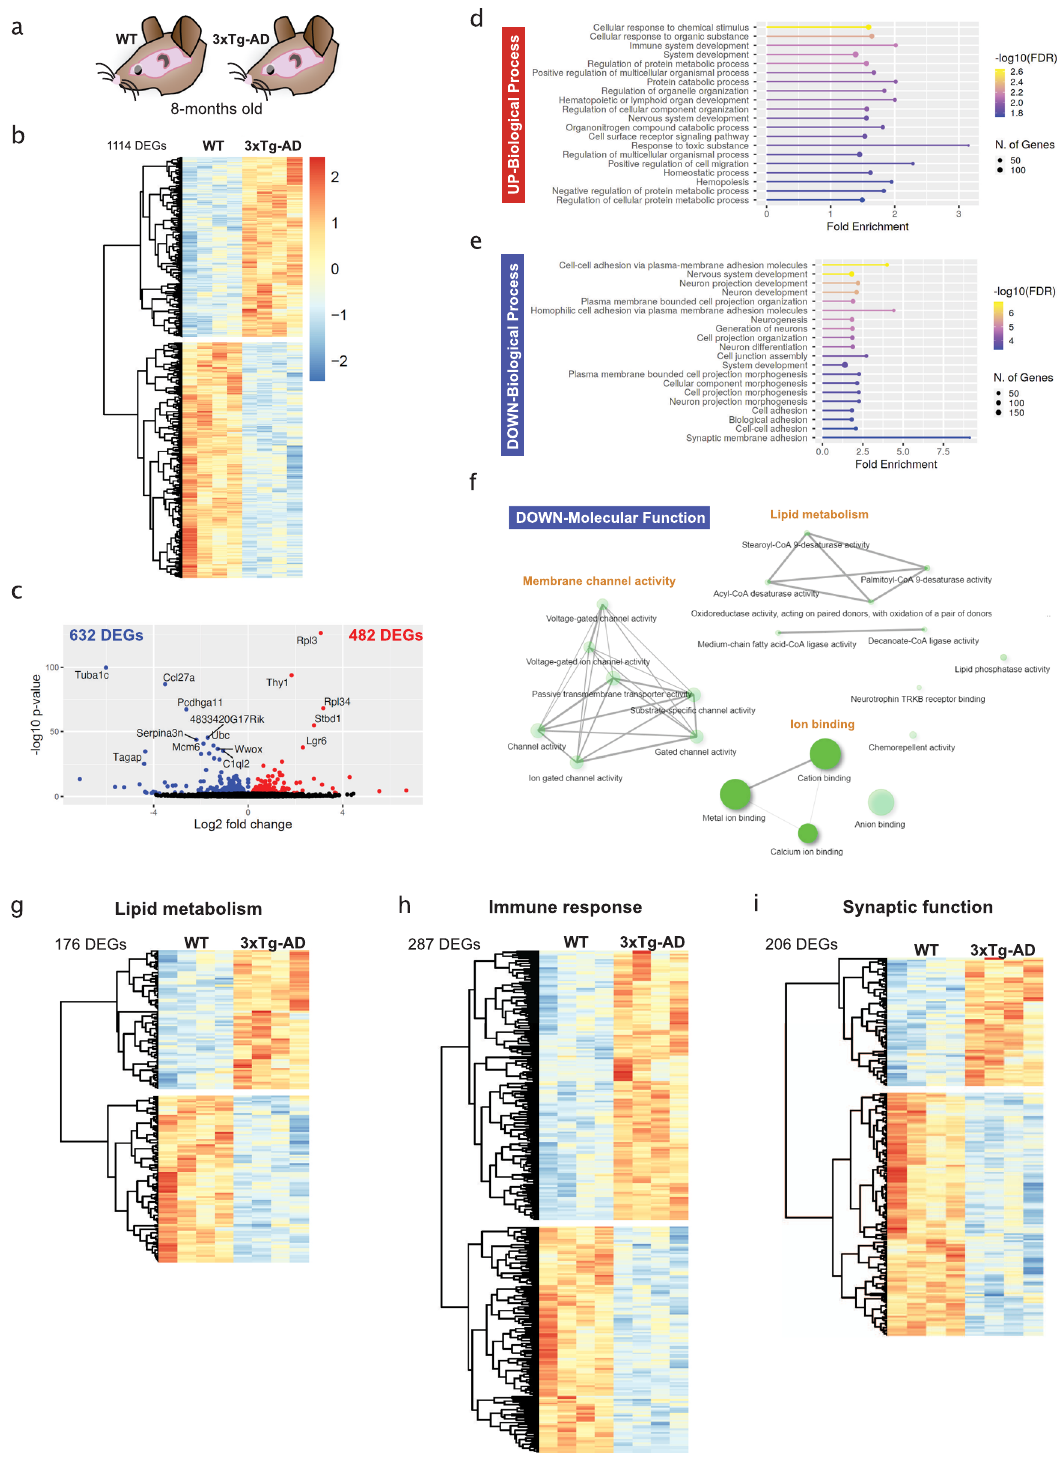
Fig. 1 Transcriptomic changes affecting the core AD processes of lipid metabolism, immune response, and synaptic function in the 3xTg hippocampus. a Experimental paradigm for the whole-hippocampus bulk RNA sequencing experiment. b Heatmap of the 1114 Differentially Expressed Genes (DEGs, p ≤ 0.01) between 8-month-old WT and 3xTg hippocampus). c Volcano plot of the 632 downregulated DEGs (blue) and 482 up-regulated DEGs (red). d – f GO enrichment analysis showing the top 20 most enriched GO Biological Process gene sets ( d , e ) and the main GO molecular function nodes ( f ). The most signi fi cant (FDR ≤ 0.05) GO biological process gene sets for up-regulated DEGs were related to cellular responses to stimuli and the immune response ( d ) while those for the down-regulated DEGs were related to nervous system development and synapses ( e ). GO molecular function gene sets were only signi fi cantly enriched for down-regulated DEGs (FDR ≤ 0.1) and are illustrated by network plots that highlight lipid metabolism, membrane channel activity and ion binding ( f ). g – i Heatmaps of the DEGs that are related to lipid metabolism ( g ), immune response ( h ), and synaptic function ( i ) (see the “ Methods ” section). Refer to Supplemental Data File 1 for the complete DEG list and the lipid metabolism, immune response, synaptic function genes.